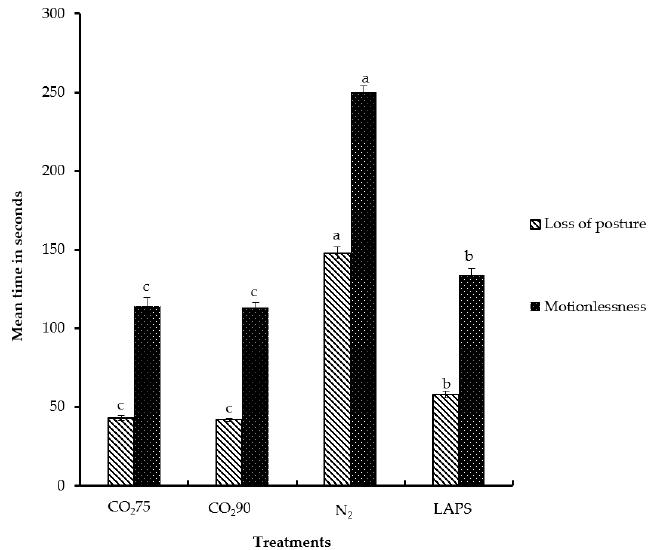
Figure 6. Mean latencies to loss of posture and motionlessness of male layer chicks. The latencies are expressed in s. Bars (mean ± SEM) with different superscripts are significantly different by Fisher’s LSD test ( p < 0.05). Number of samples per treatment was 10.